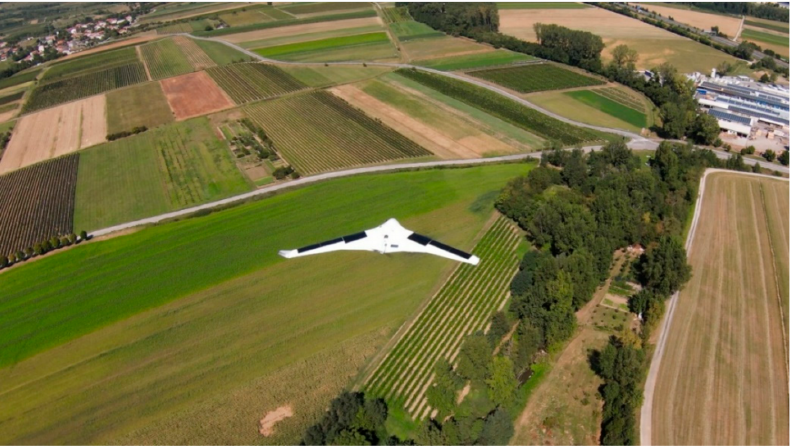
Figure 16. A photo of the Bramor ppX UAV equipped with solar modules, captured during the flight. All currents and voltages were measured and saved on the logger’s memory card.